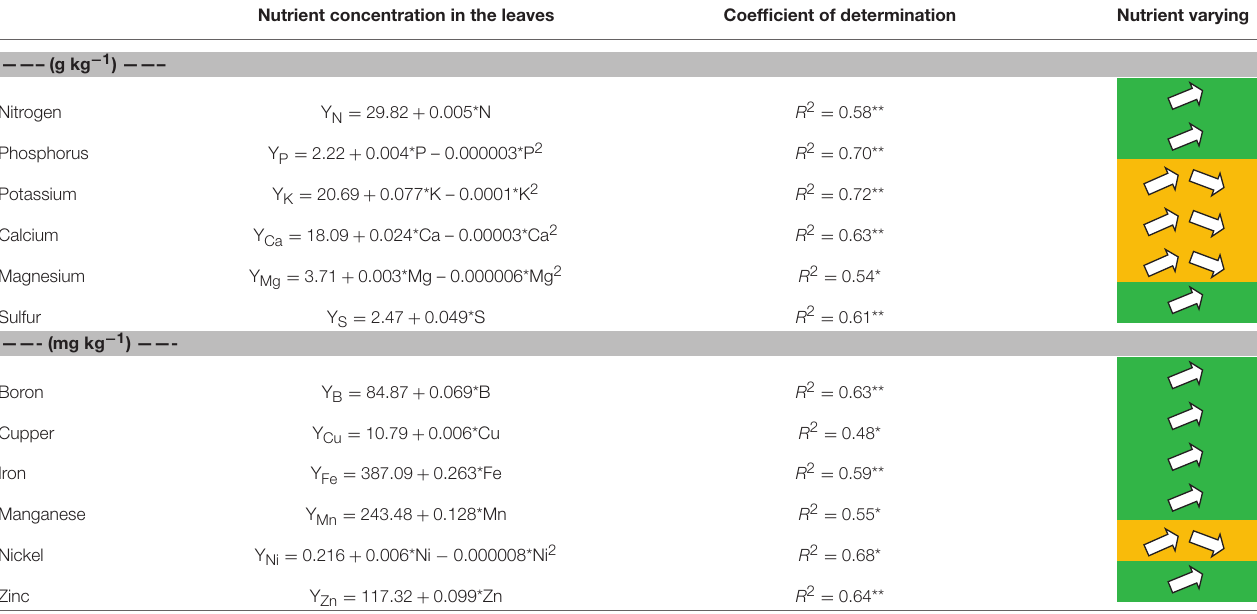
TABLE 2 | Concentration [Y] of nitrogen (N), phosphorus (P), potassium (K), calcium (Ca), magnesium (Mg), sulfur (S), boron (B), cupper (Cu), iron (Fe), manganese (Mn), nickel (Ni), and zinc (Zn) taken on the leaves of soybean cultivar BMX Potência RR , collected at R1 phenological stage (Fehr et al., 1971 ), as related to Ni seed treatments